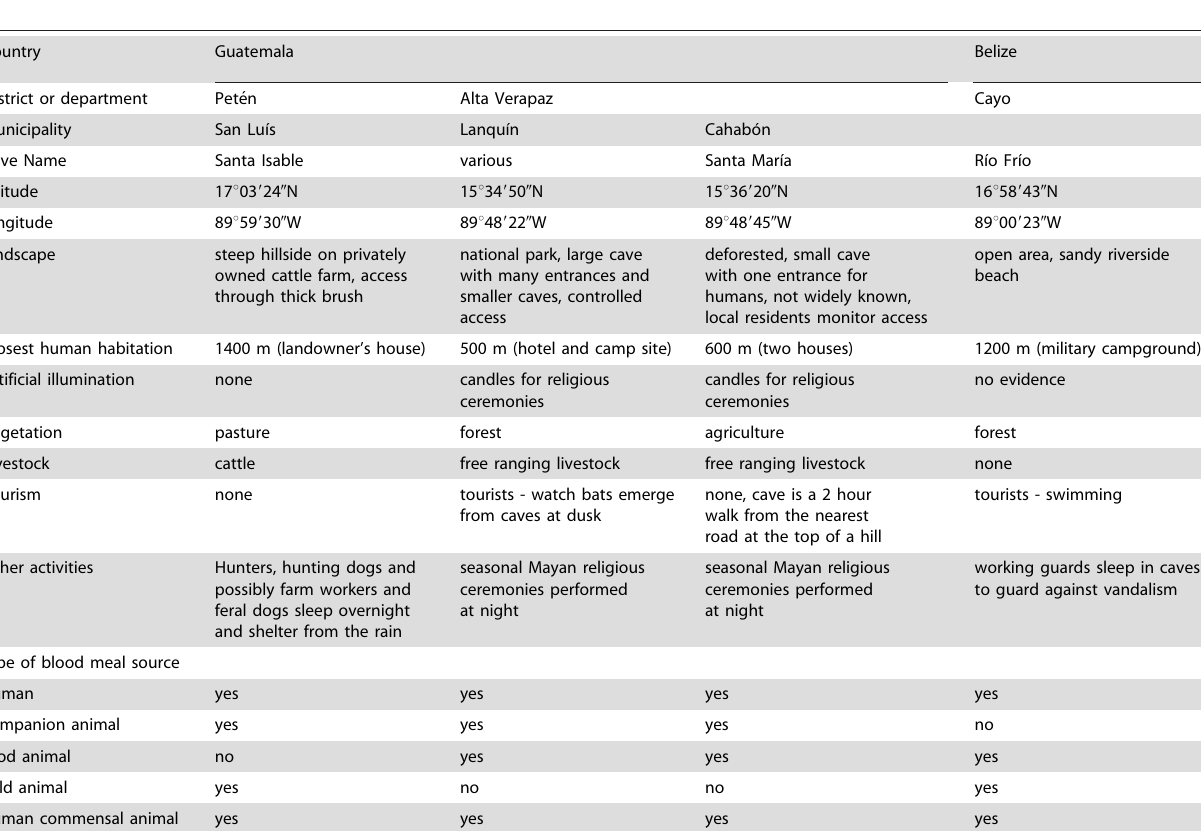
Table 1. Cultural practices and anthropic alterations around the caves where the Chagas disease vector, Triatoma dimidiata , was